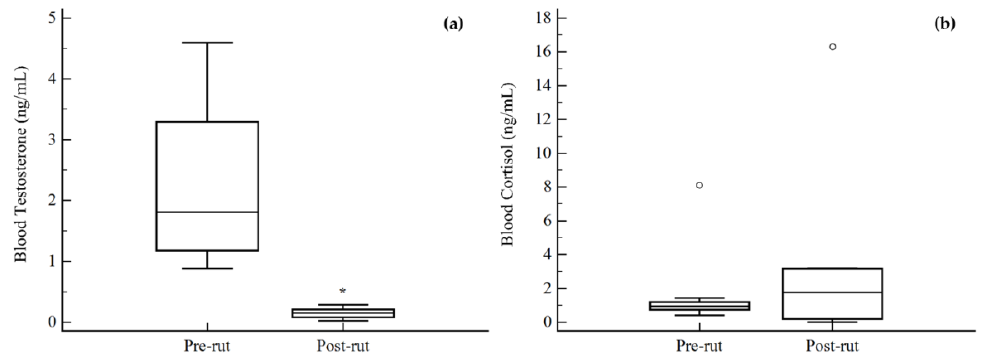
Figure 1. Differences between pre- and post-rut groups for the testicular morphometric parameters. ( a ) Testicular volume; ( b ) testicular weight. ○ outlier; * p < 0.05.